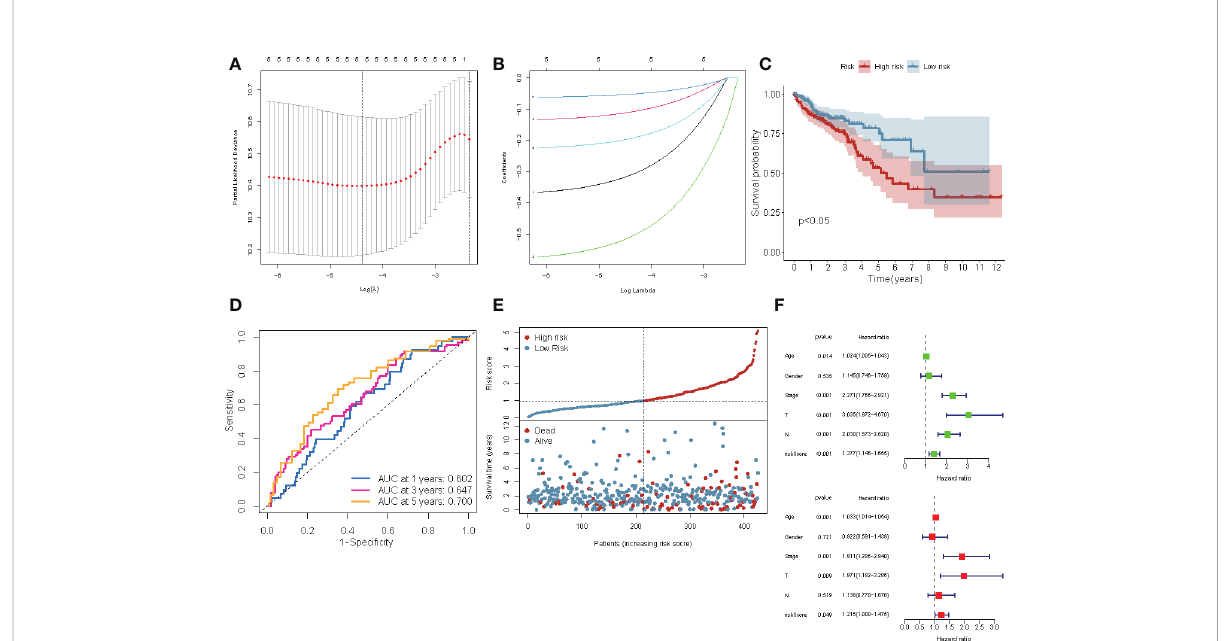
FIGURE 5 Construction of the four-gene prognostic risk model based on the TCGA-COAD cohort. (A) Screening of optimal parameters (lambda) in the LASSO regression model based on the TCGA cohort. (B) LASSO coef fi cient pro fi les of the 4 ERDEGs determined by the optimal lambda. (C) The Kaplan-Meier survival curve for the OS of patients with COAD patients in the high- and low-risk groups from TCGA cohort. (D) The ROC curve of the prognostic model shows the OS and survival status in TCGA cohort. (E) Scatterplots at the top and bottom show the distribution of the risk score and survival status in patients with COAD, respectively. (F) Univariate and multivariate Cox regression analyses of the risk score and clinicopathological parameters in TCGA